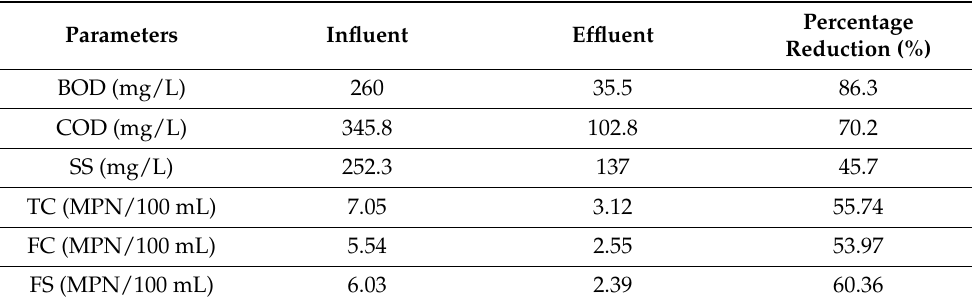
Figure 9. Cross-sectional depiction of worm tank in vermicompost-based treatment system inte- grated with single-household toilets. Reused under the Creative Commons license (CC BY-NC-SA 4.0) [54]. Table 1. Comparison of influent and effluent characteristics of the sludge. Data mentioned here are procured from the work of Sudipti Arora et al. [55] .